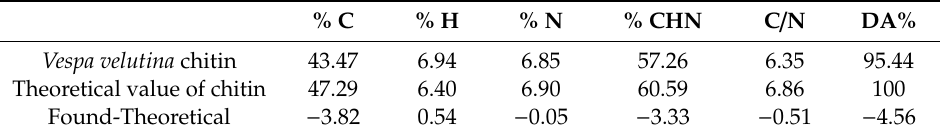
Table 1. Elemental composition measurements and theoretical values for chitin from Vespa velutina . % C % H %